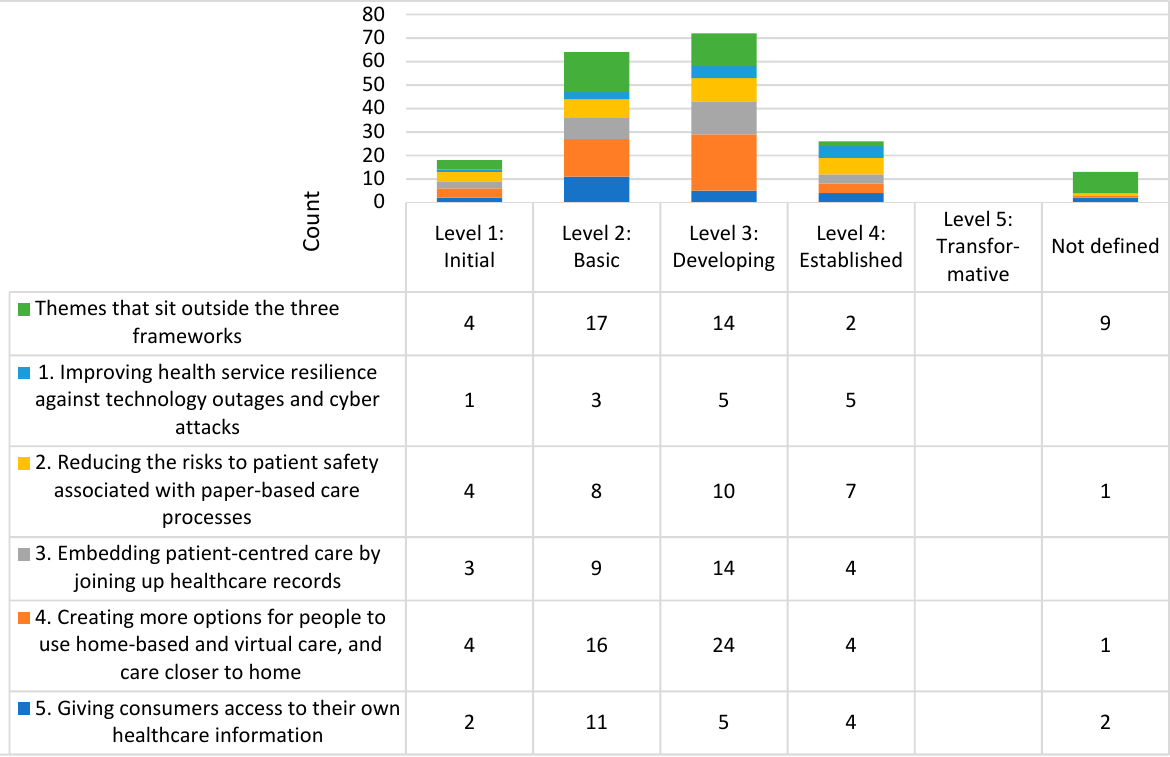
Figure 1. Histogram of self-rated digital maturity across the eight health services. NB each number represents the number of times (counts) the domain and level were mentioned in the focus groups.